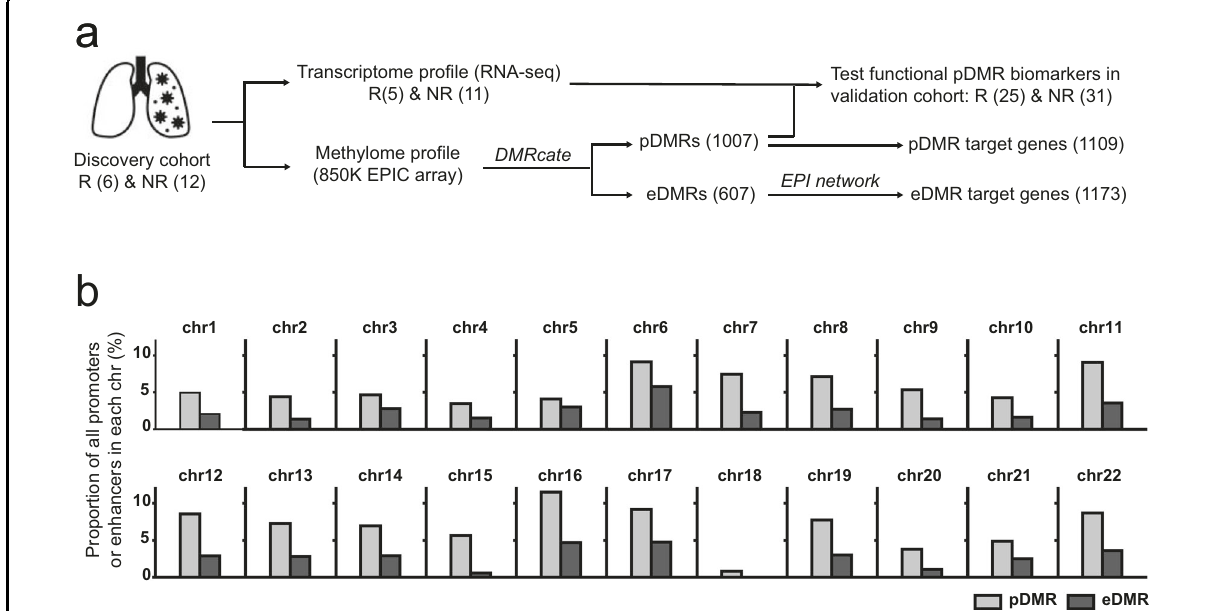
Fig. 1 Methylomic features of the anti-PD-1 response in NSCLC patients. a Overview of the study design and summary of the results. b Proportion of differentially methylated promoter or enhancer regions normalized by the total number of promoters or enhancers for each